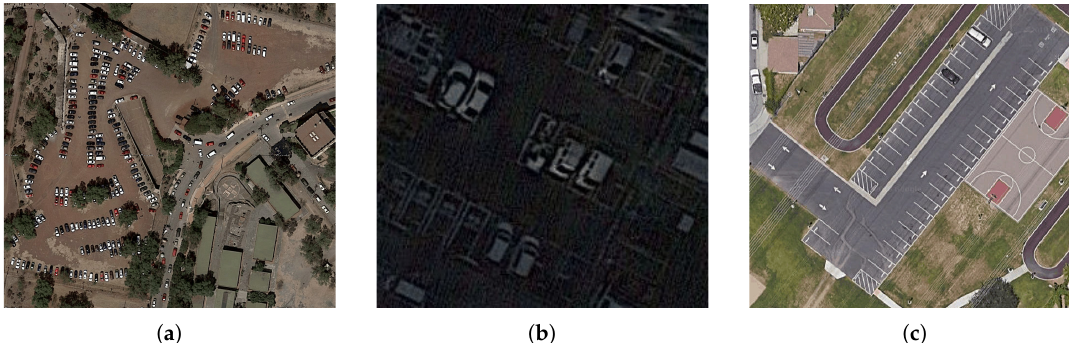
Figure 3. Parking lot examples from satellite perspective: ( a , b ) were both excluded from our dataset given the poor demarcation in the former and poor lighting conditions in the latter. In contrast, ( c ) is a great example that was included in our